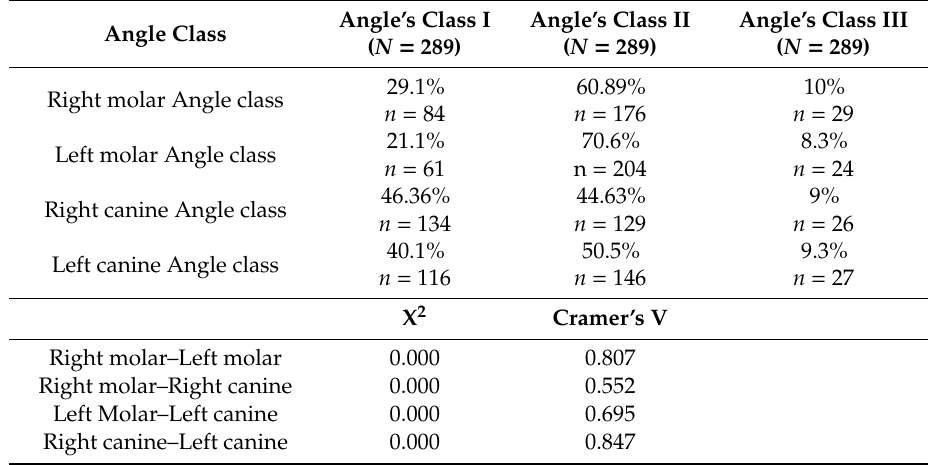
Table 2. Mouth valuation of the participants, angle class, and correlation between